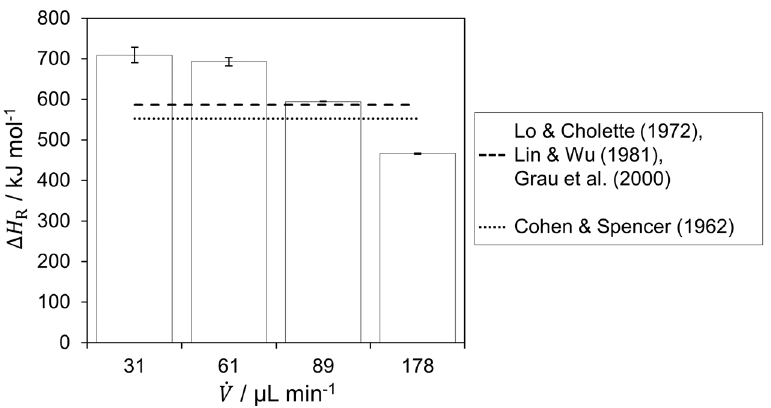
Figure 4. Determined reaction enthalpy from the experiments for the respective flow rates and comparison with literature [33–36]. comparison with literature